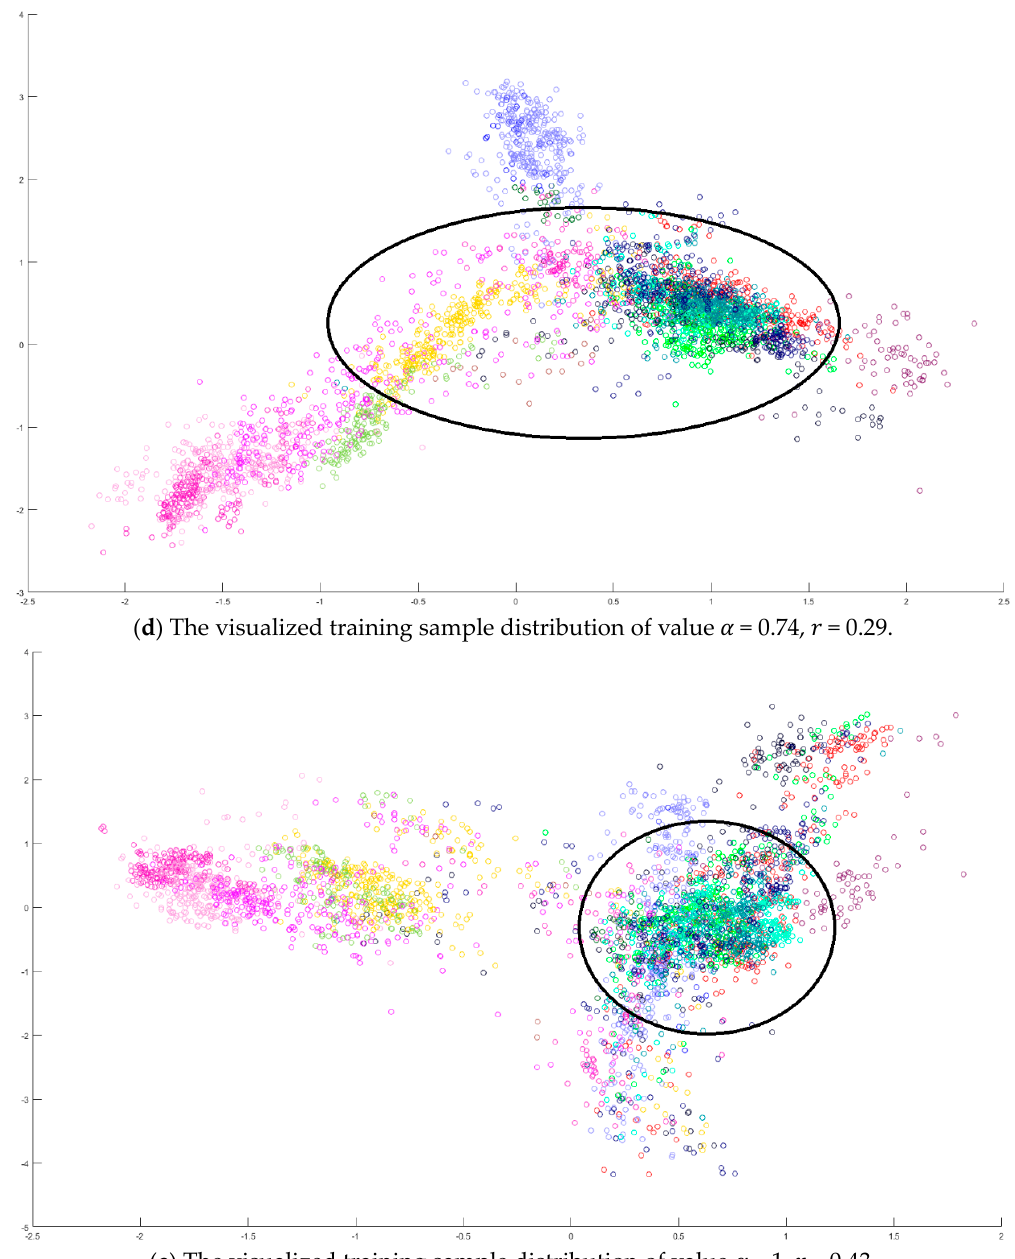
Figure 10. The analysis for the training data in dataset IPS: ( a ) The overlapping degrees of various values α , ( b ) The visualized training sample distribution of PCA and r = 0.51, ( c ) The visualized training sample distribution of value α = 0 and r = 0.42, ( d ) The visualized training sample distribution of value α = 0.74 and r = 0.29, and ( e ) The visualized training sample distribution of value 𝛼 = 1 and 𝑟 = 0.43.